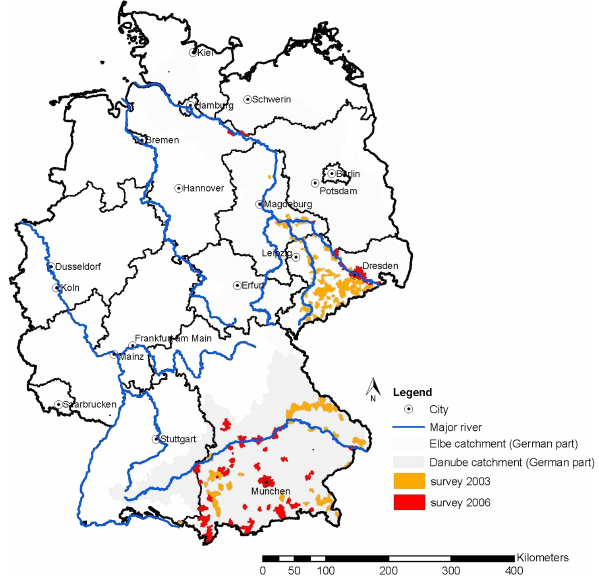
Figure 1. A map of the survey locations and river catchment